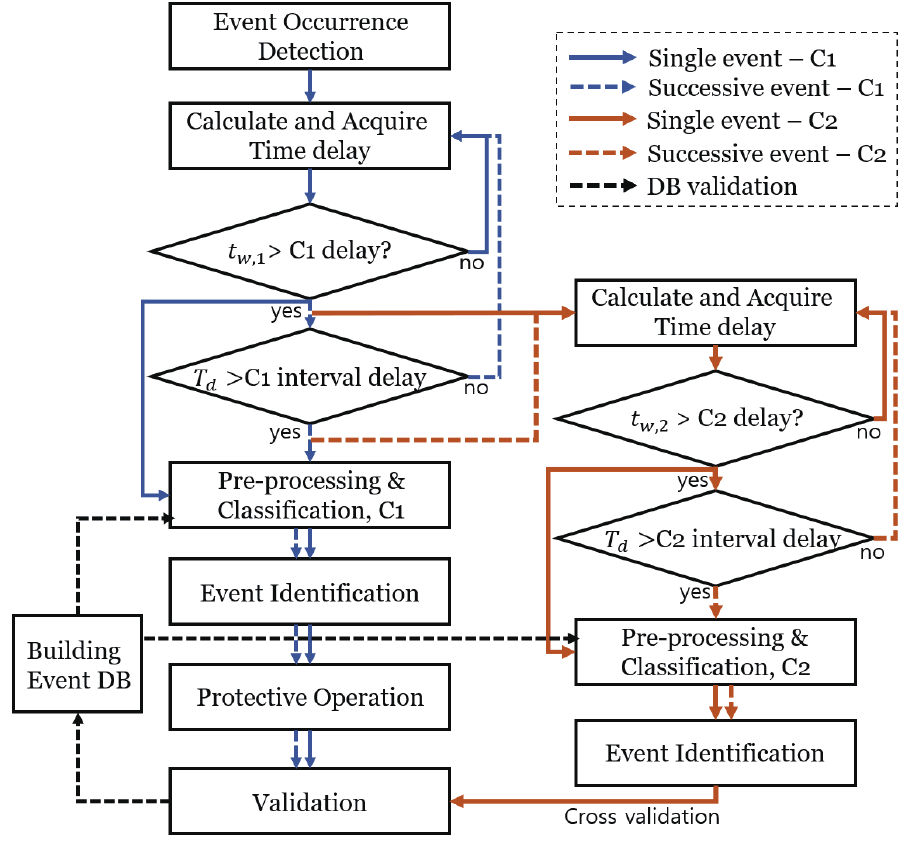
Figure 5. The proposed flow chart of complementary sequence event identification and protective